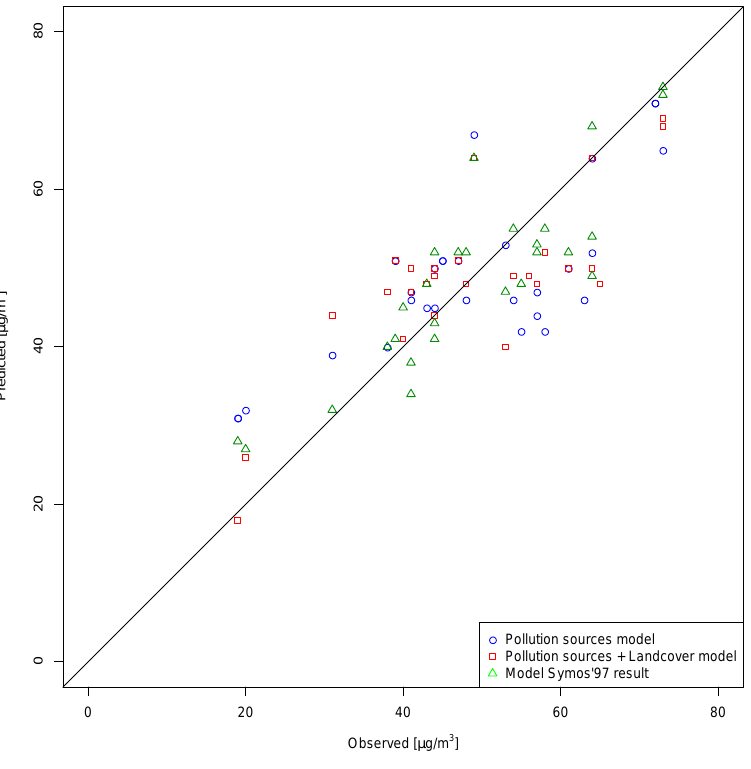
Figure 5. Observed to predicted comparison of results.